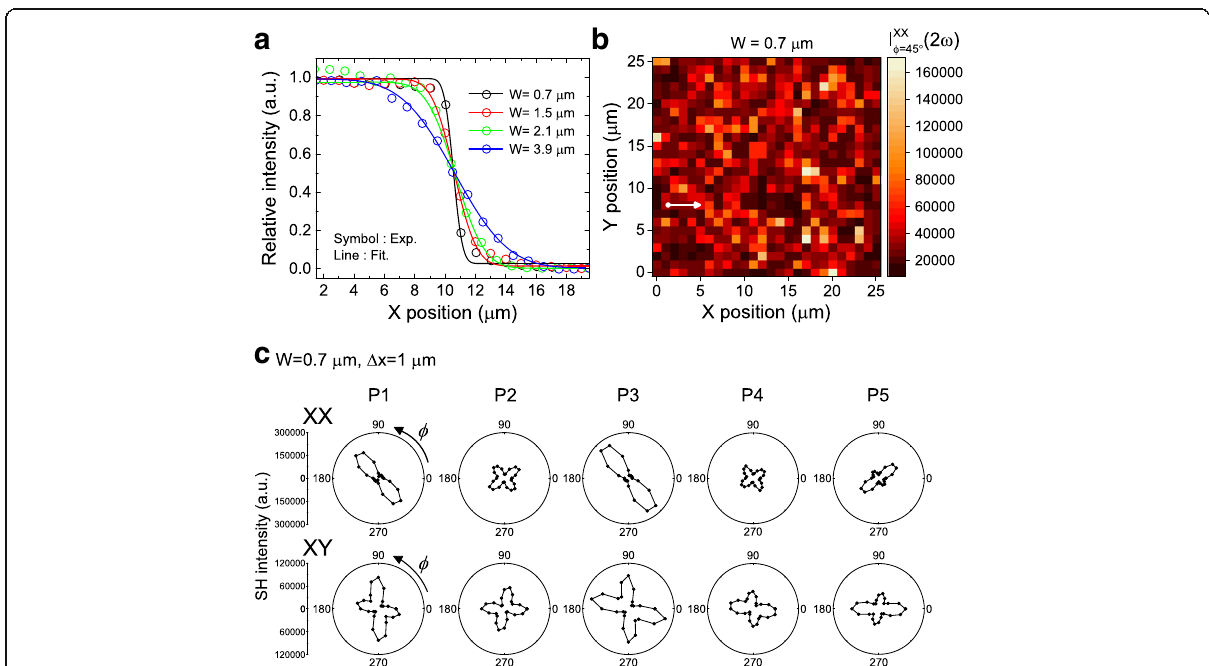
Fig. 2 Second harmonic generation (SHG) results obtained with a beam size of 0.7 μ m. a Knife-edge experimental results to characterize the beam size. b The SHG intensity mapping image obtained with a beam size 0.7 μ m over the area of 25 × 25 μ m 2 . c Azimuth-dependent polar plots of the SHG intensity obtained at different sample positions along the arrow in